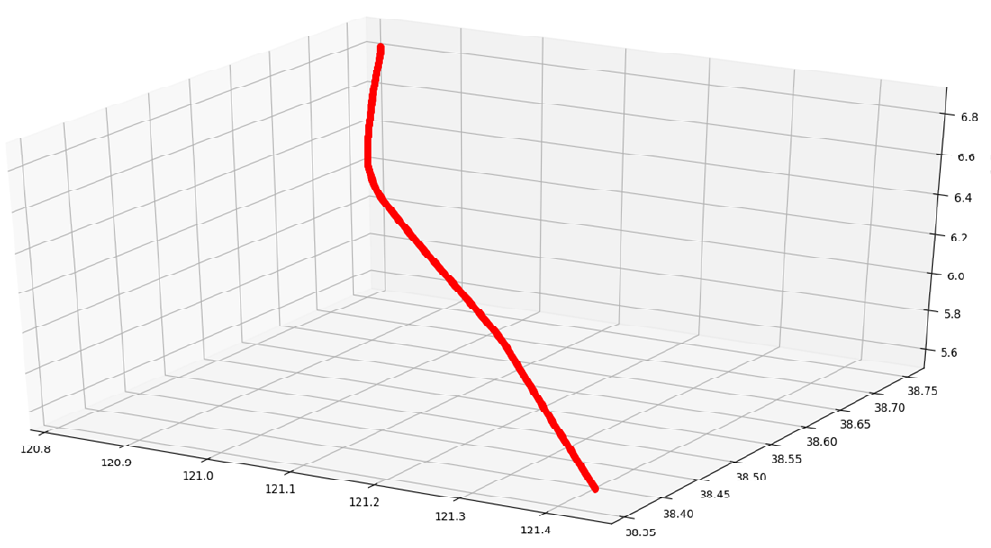
Figure 8. The original AIS trajectory of the single ship.